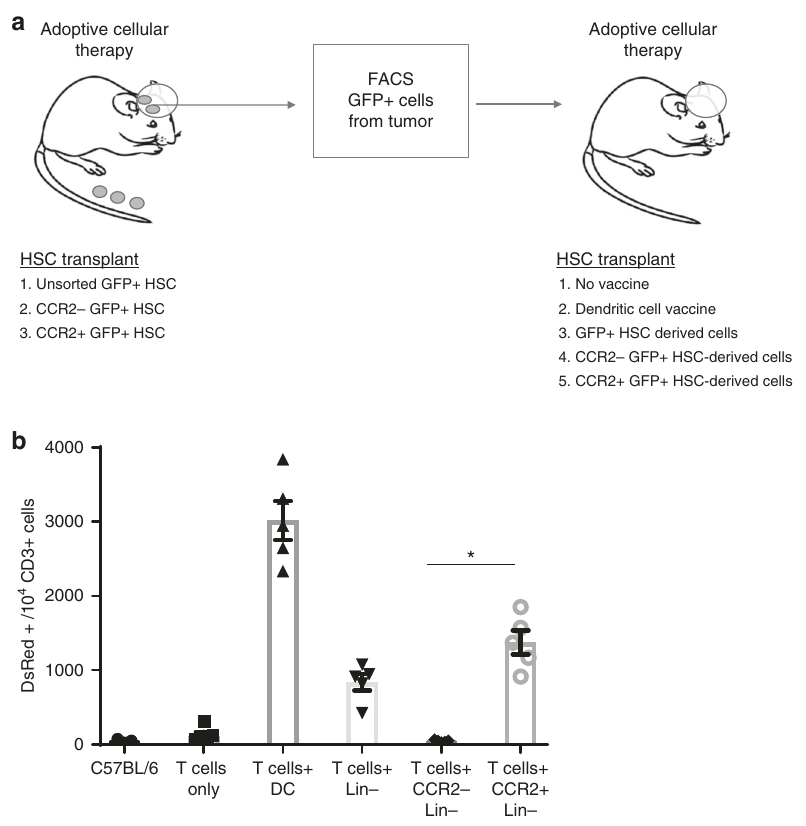
Fig. 7 CCR2 + HSC-derived dendritic cells expand T-cells in adoptive cell therapy. a Experimental description. b Cells derived from GFP + HSCs, GFP + CCR2 − HSCs, or GFP + CCR2 + HSCs were isolated from the tumors of mice treated with adoptive cell therapy. These were then used as a vaccine in a second cohort of mice treated with adoptive cell therapy using DsRed + tumor-reactive T cells. Vaccine draining lymph nodes were harvested and relative amounts of DsRed + T-cells were measured between the group that received CCR2 + HSCs and the groups that received cells derived from CCR2 − HSCs (* p = 0.0001, t -test, n = 3 replicates per group). All error bars represent